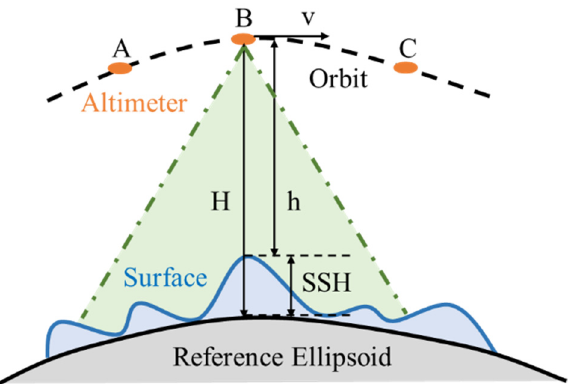
Figure 3. Geometric schematic diagram of height measurement by radar altimeter.